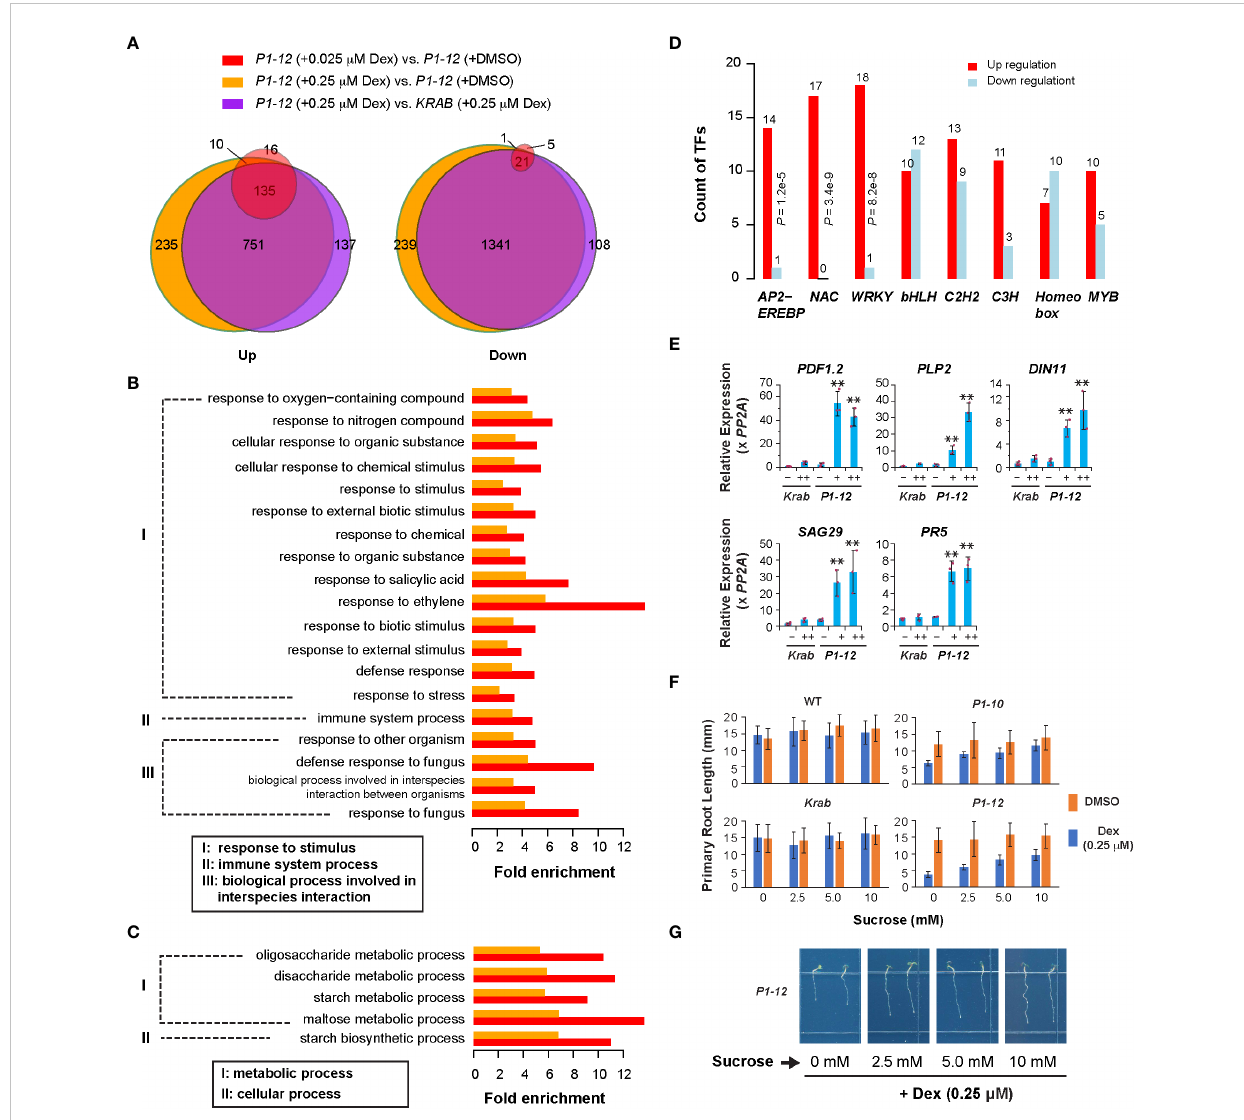
FIGURE 3 Transcriptome analysis revealed a role of MORF2 in regulating plant stress defense. (A) Overlap of SDEGs in three indicated pairs of transcriptomes suggests a little impact of dCas9-KRAB overexpression but a large impact of MORF2 reduction on transcriptome changes in P1-12 . A gene was retained for comparison if its Counts Per Million (CPM) was above 2 in at least nine samples from two replicates each of P1-12 (+DMSO), P1-12 (+0.025 m M), P1-12 (+0.25 m M), KRAB (+DMSO) and KRAB (+0.25 m M). (B, C) Enrichment of biological processes in up (B) and downregulated (C) SDEGs of P1-12 seedlings treated with 0.025 m M (red bars) and 0.25 m M (orange bars) Dex demonstrated upregulation of stress response. (D) Overrepresentation of three major stress responsive transcription factor families, APETALA2/ETHYLENE-RESPONSIVE ELEMENT BINDING PROTEIN ( AP2-EREBP ), NO APICAL MERISTEM/ARABIDOPSIS TRANSCRIPTION ACTIVATION FACTOR/CUPSHAPED COTYLEDON ( NAC ), and WRKY , in upregulated SDEGs of P1-12 seedlings treated with 0.25 m M Dex. P values indicated were calculated using Fisher ’ s exact test. (E) qPCR veri fi cation of fi ve stress defensive genes. Relative expression of a target gene is normalized to one of the three KRAB biological replicates treated with DMSO. Bars and the maroon dots are described as in Figure 1G. Double asterisks represent a statistically signi fi cant upregulation of an indicated gene in P1-12 seedlings treated with Dex compared to those treated with DMSO only (Student ’ s t -test, P < 0.01). – : DMSO; +: 0.025 m M Dex; ++: 0.25 m M Dex. (F) Sucrose promotes root growth of light-grown P1-10 and P1-12 seedlings only when treated with 0.25 m M Dex. Each bar represents mean ( ± SD) of 20 to 24 seedlings analyzed. WT and KRAB seedlings were included as negative controls. (G) Representative images of P1-12 seedlings grown on 0.25 m M Dex-containing 1/2 MS media supplemented with different concentrations of